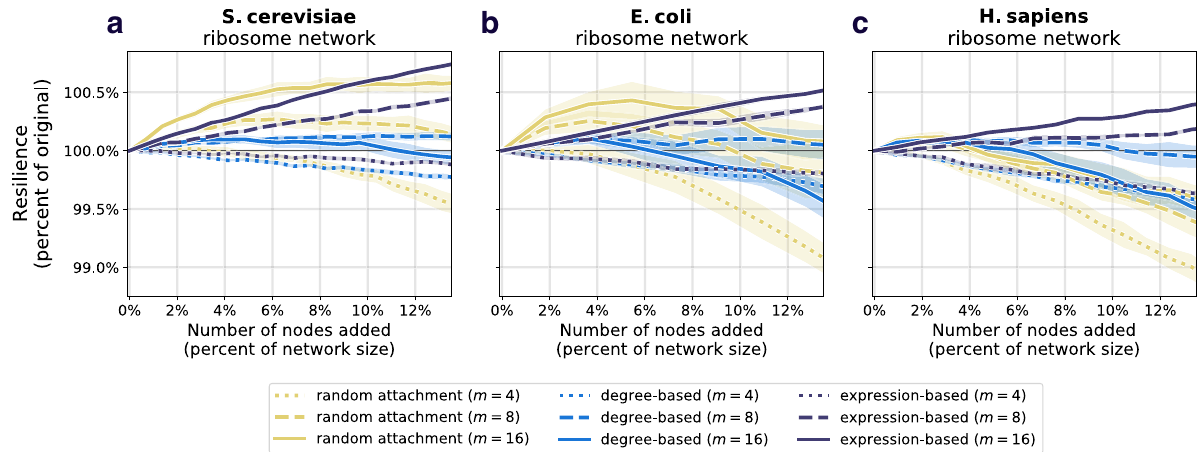
Fig. 4 Prospective resilience of three ribosomal networks. As more nodes are added (horizontal axes), the resilience of the resulting network changes (vertical axes). The color of each curve corresponds to the number of new links that each new node enters the network with, and the line style (solid, dashed, or dotted) corresponds to the three different node attachment mechanisms. a Prospective resilience of S. cerevisiae ribosomal network. b Prospective resilience of E. coli ribosomal network. c Prospective resilience of H. sapiens ribosomal network. Ribbons around each curve correspond to their 95% con fi dence